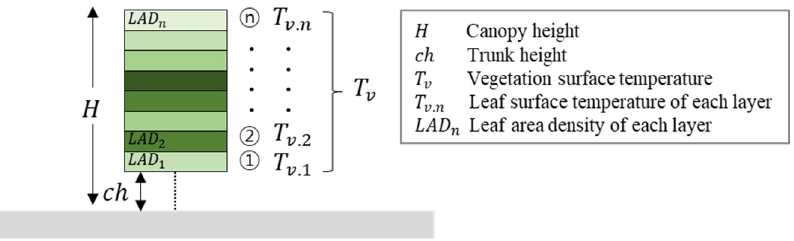
Figure 2. Model base domain.